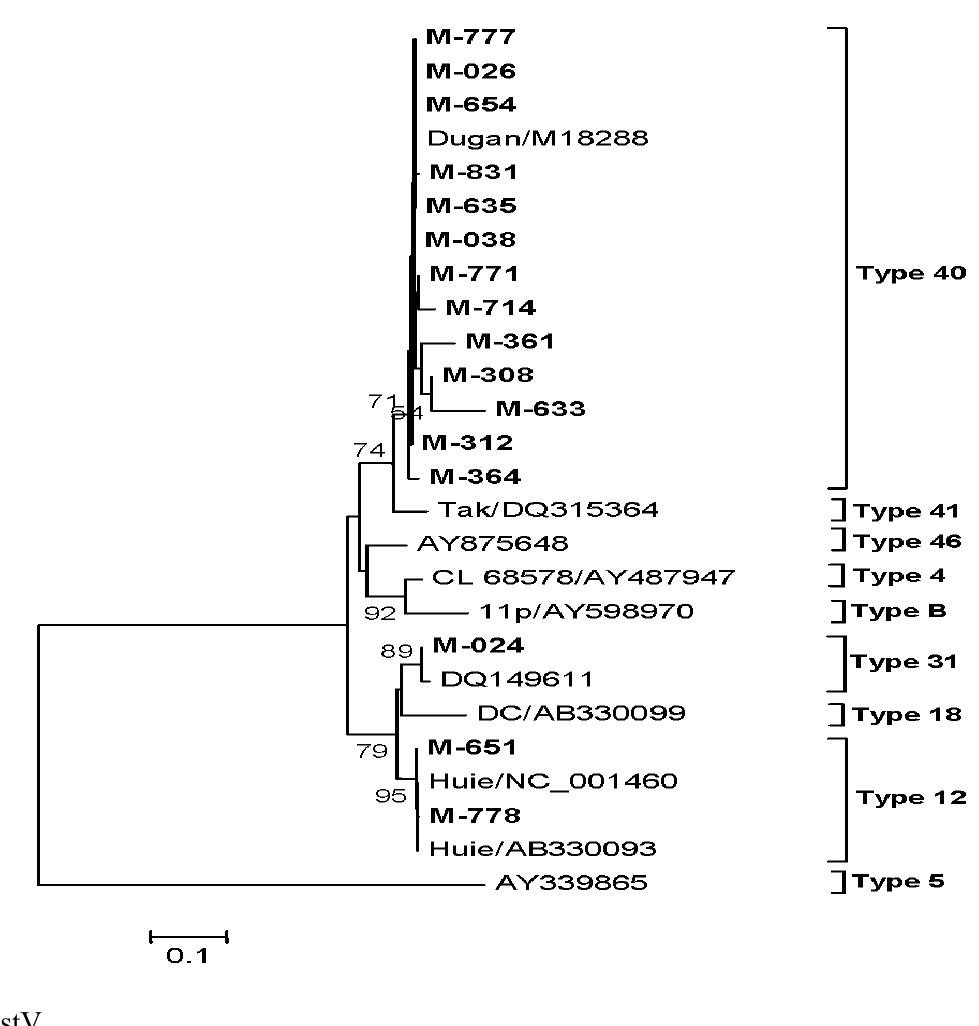
Figure 5. Phylogenetic tree based on the partial nucleotide sequences of Hexon gene (250 bp) of AdV strains. The strains of the present study are in bold face. Scale indicates genetic